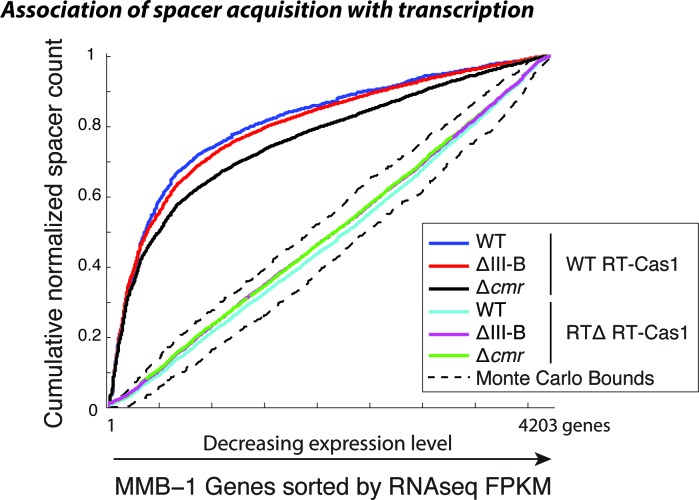
Spacer acquisition in the absence of type III-B interference.Cumulative normalized distribution of spacers in (A) among M. mediterranea genes sorted by RNAseq FPKM (fragments per kb per million reads), with genes ordered by decreasing expression level. Each dataset includes spacers from two separate transconjugants. Numbers of recovered spacers analyzed were as follows: 4093 WT, 21629 ∆III-B, 7341 ∆cmr with WT RT-Cas1, and 20780 WT, 43587 ∆III-B, 55026 ∆cmr with RT∆ RT-Cas1. The linear relationships observed in the presence of RTΔ RT-Cas1 indicate no correlation between spacer acquisition and mRNA transcription levels, which is consistent with spacer acquisition from DNA. Spacers acquired with WT RT-Cas1 show preferred acquisition from highly expressed genes, indicative of spacer acquisition from RNA substrates. Dashed black lines show the range of values from a Monte-Carlo simulation with random assortment (no transcription-related bias).